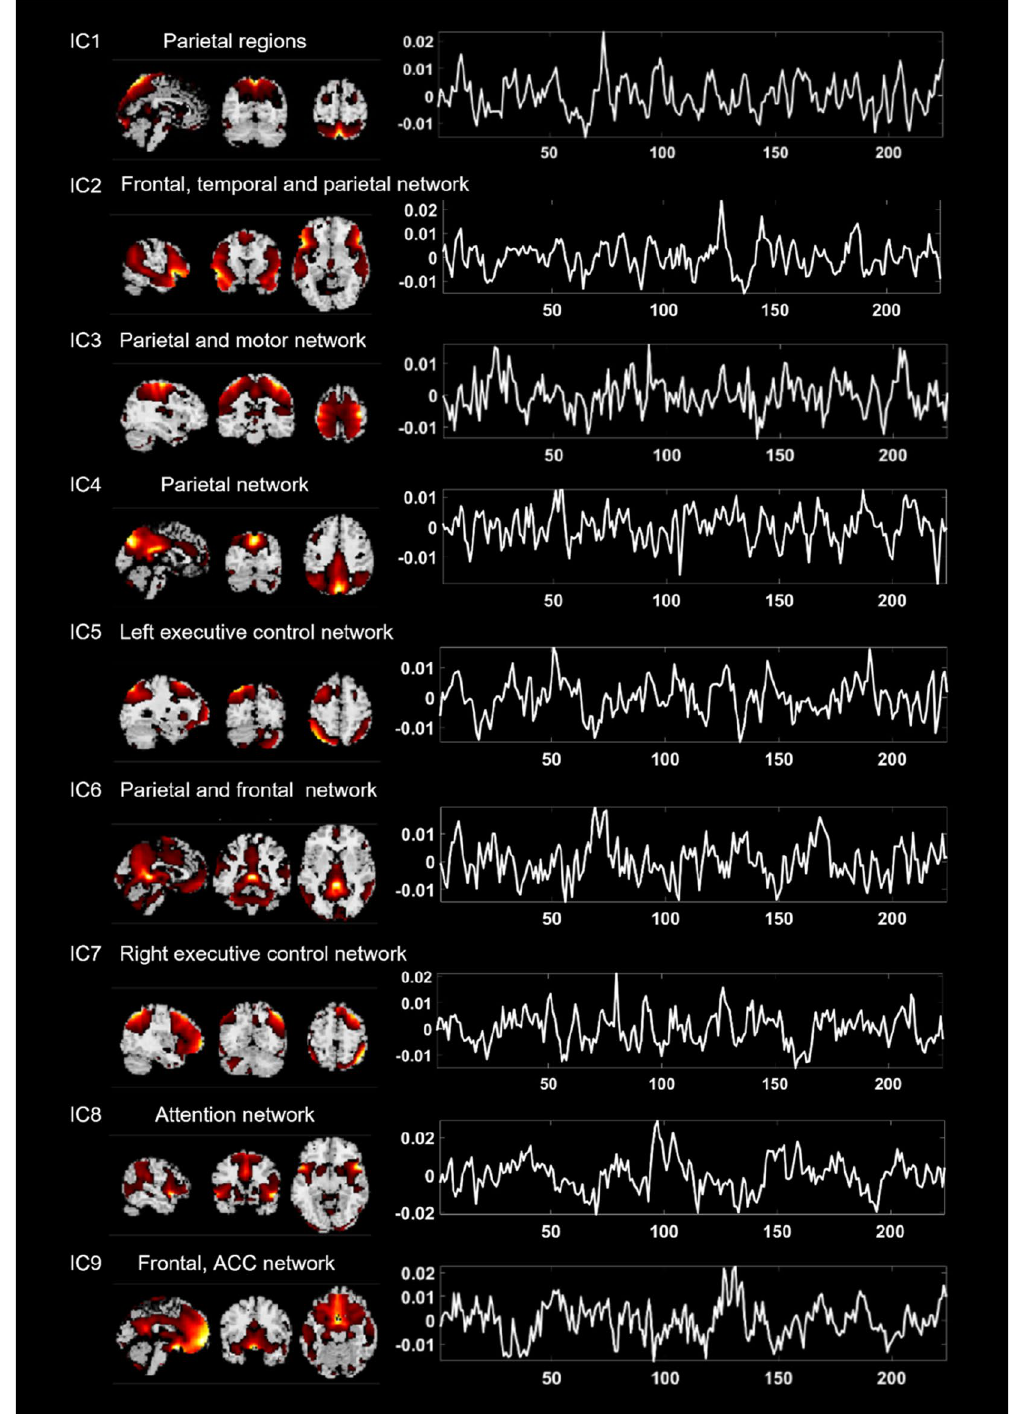
Figure 2. Spatial maps ( Z -threshold > 1.0, in the left panel) and time series (in the right panel) for selected independent components of the mean for all